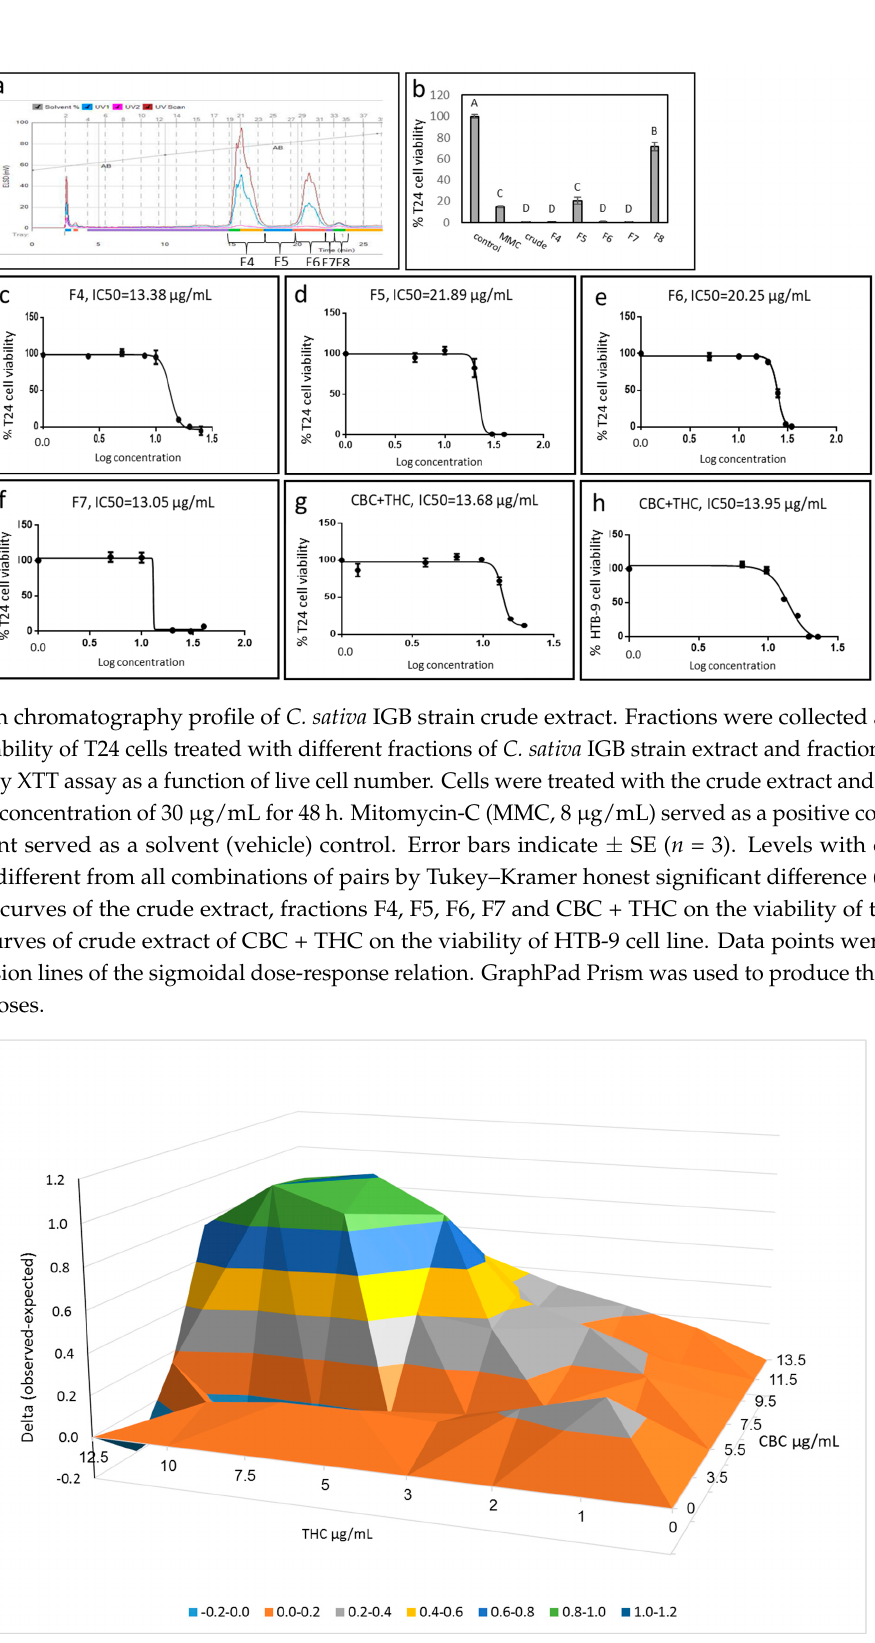
Figure 2. Synergistic interactions between CBC and THC on cell viability of T24 cells following combined treatments. Synergy of cytotoxic activity calculated using the Bliss independence drug interaction model. Synergy is apparent when the experimental (observed) value of cell death is higher than the calculated (expected) value. Delta between the observed and expected values, calculated using the Bliss model are shown in the Y axis.